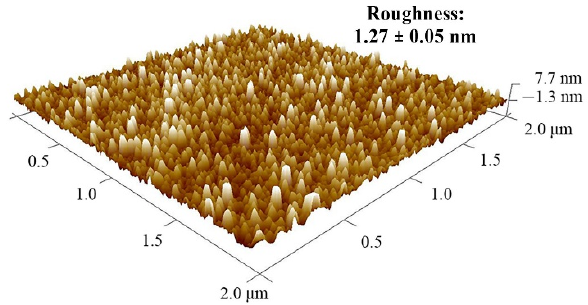
Figure 1. AFM images of NiFe films with a thickness of 100 nm.